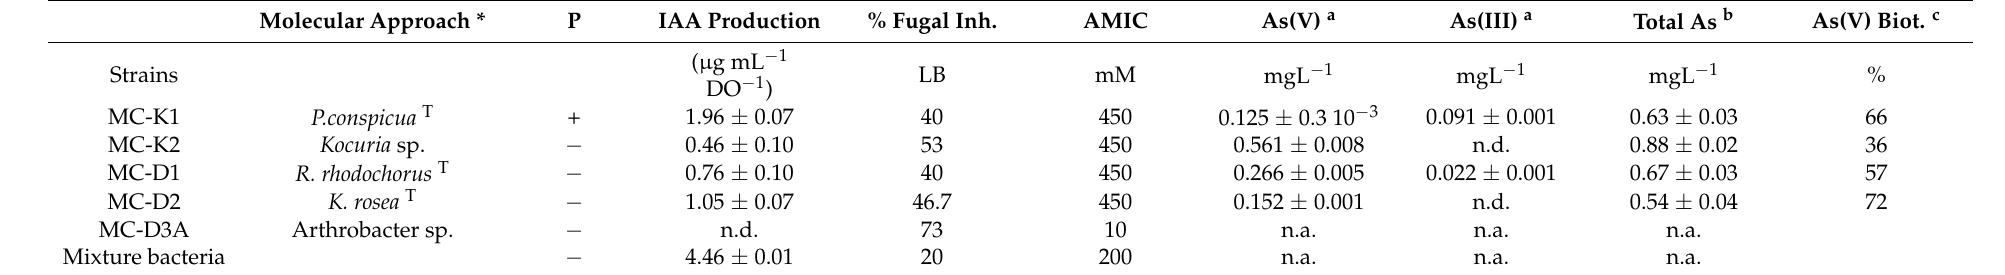
Table 1. Molecular identification (similarity > 99.5%) and characterization of five endophytic bacteria (and a mixture of all of them) from J. montana growing on arsenic contaminated soil: ability to solubilize inorganic phosphate, to produce IAA, to inhibit the growth of Alternaria sp., and arsenic species and total arsenic concentrations within bacteria growing at 10 mM